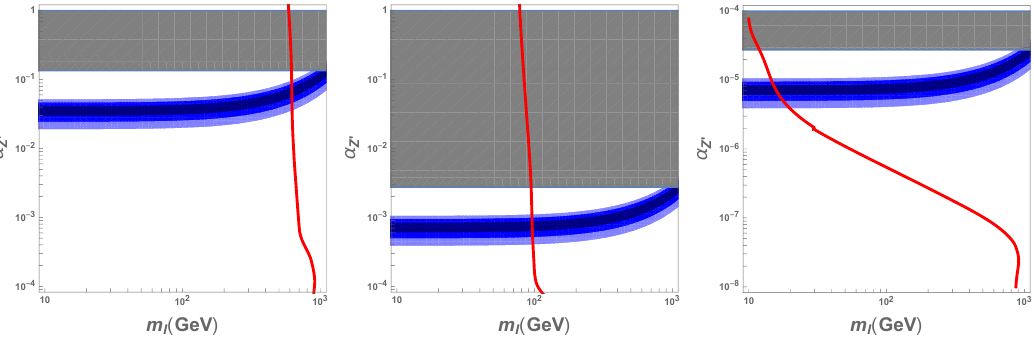
Figure 12 . The C (cid:22); NP which solves the b s(cid:22)(cid:22) anomaly at 1 (cid:27) (dark blue), 2 (cid:27) (blue), and 3 (cid:27) 9 ! (light blue) in ( m I ; (cid:11) Z 0 ) plane. We take m Z 0 = 700 ; 100 ; 10 GeV (from the left panel). We (cid:12)xed q X = 2, (cid:21) s (cid:21) (cid:3) = 0 : 2, M D = 1 TeV, and m R = 3 TeV. They are superimposed with the constant b lines for (cid:10) DM h 2 = 0 : 1199 shown in (cid:12)gure 10. The grey regions are excluded by the neutrino trident production experiments at 2 (cid:27) level.